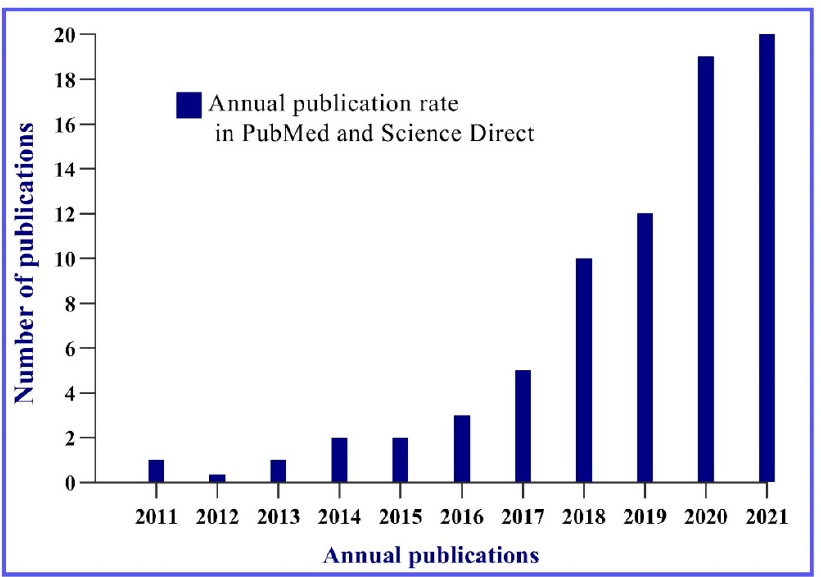
Figure 1. Graphical representation of the perspective of publications on the use of bacterial cellulose in cosmetics in the last decade.